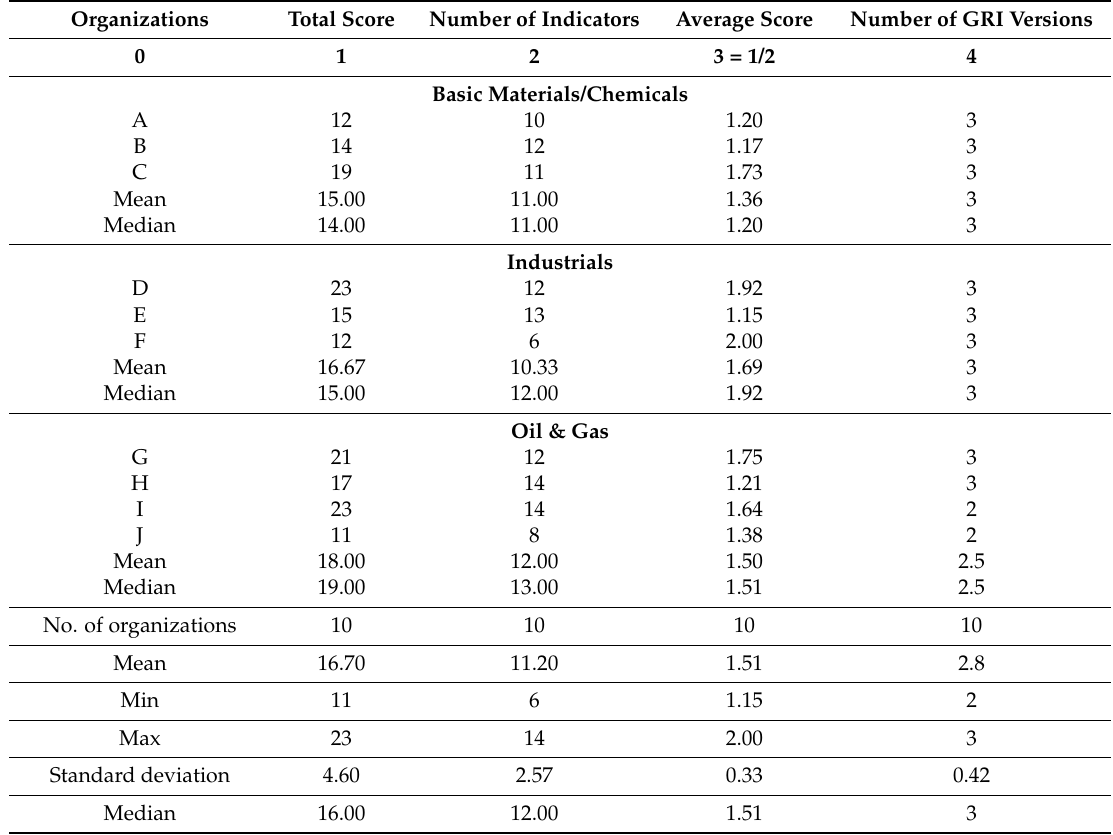
Table 6. The score of the EPI